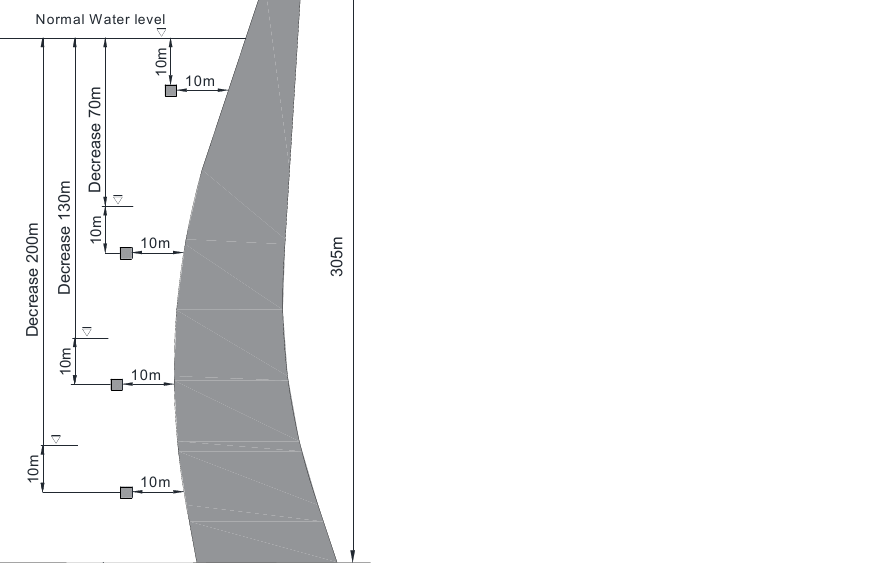
Figure 22. Position of detonation in front of the dam at various water levels.